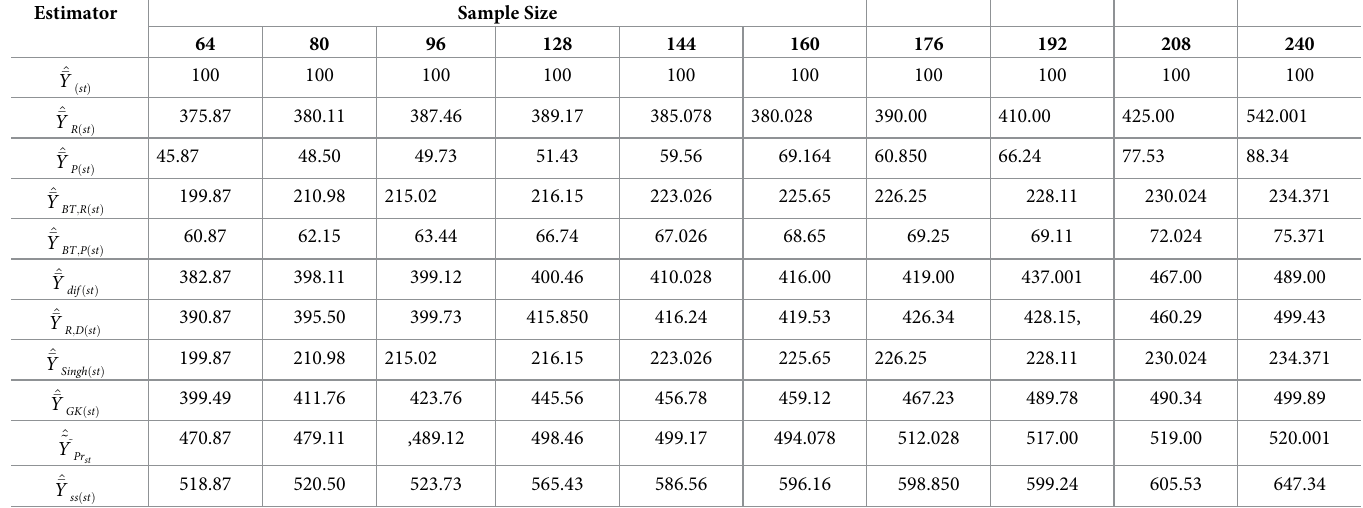
Table 7. Simulation results for the PRE of recommended estimator w.r.t the existing estimators by different sample sizes. Estimator Sample